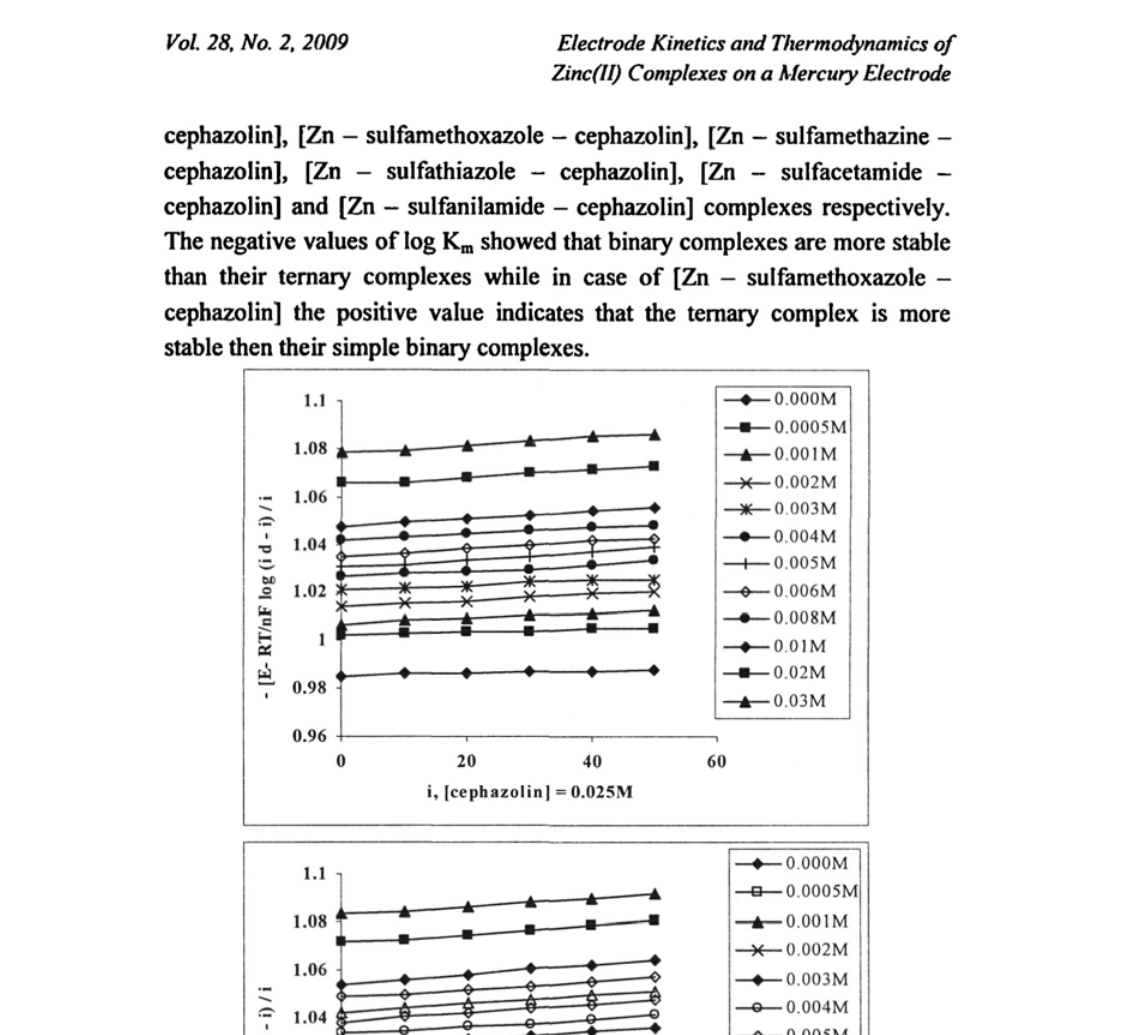
Fig. 1: Plots between - [E-RT/nF log (ij-iyi] vs i for [Zn - sulfadiazine - cephazolin]